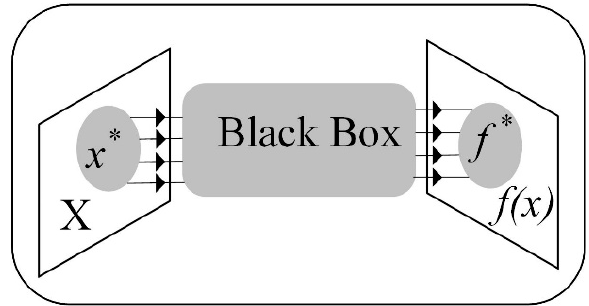
Figure 3. Optimization of black-box systems.